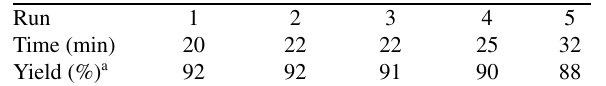
Table 5. Recyclability study of 20CuO/ZnO